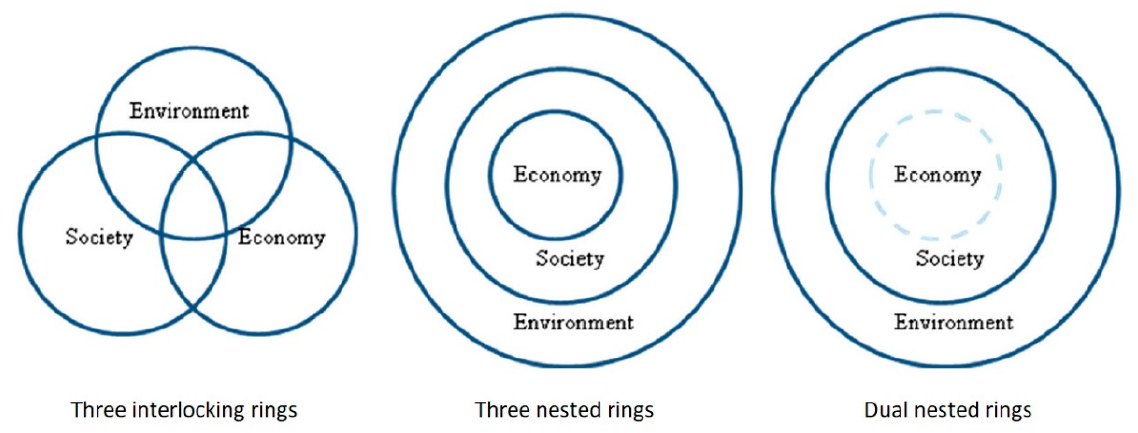
Figure 2. Conceptualizations of sustainable development [37].